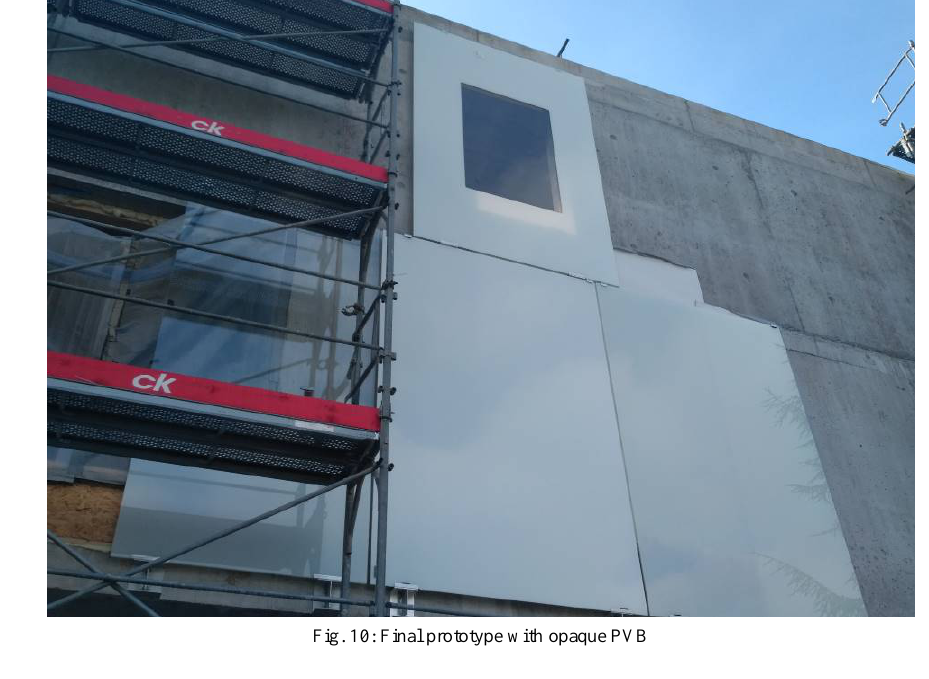
Fig. 10: Final prototype with opaque PVB